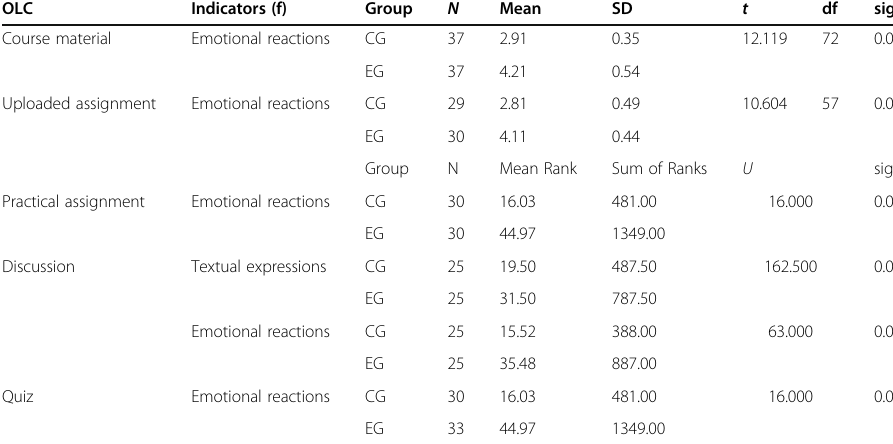
Table 11 Comparison of indicators of emotional engagement scores OLC Indicators (f)